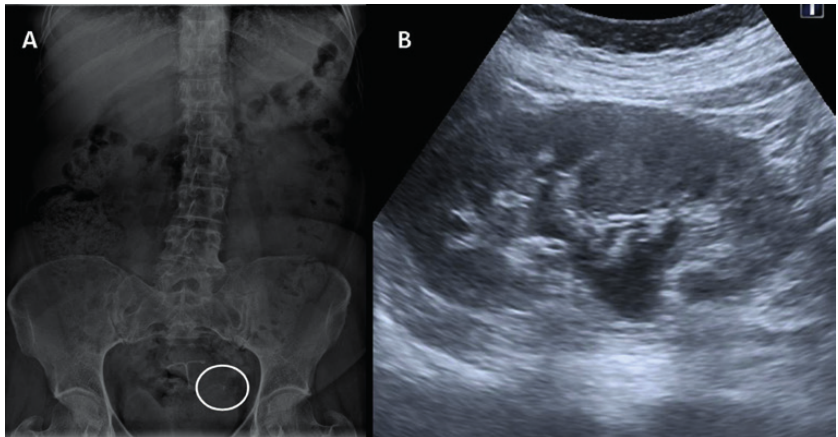
figure 1 - A) Abdominal X-ray with left pelvic calcification (white circle); B) Ultrasound image showing grade II left